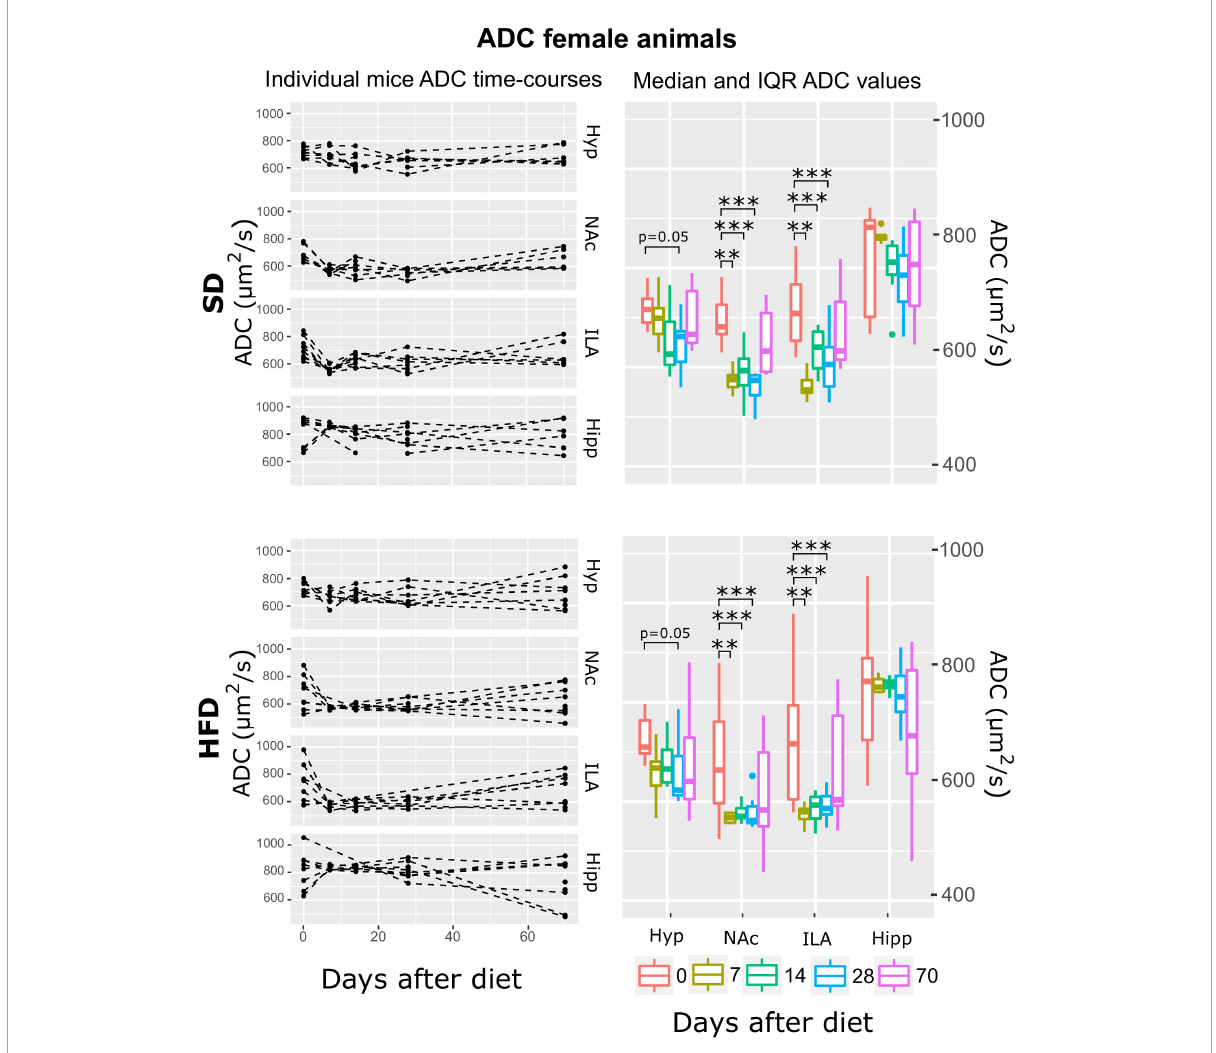
FIGURE7 ADC changes on female mice during HFD or SD consumption. ADC time-evolution on SD-fed (top panels) or HFD (bottom panels) female mice in the four brain areas assessed: hypothalamus (Hyp), nucleus accumbens (NAc), ipsilateral area (ILA) and hippocampus (Hipp) at all time points measured. Left panels depict the individual regional values at each time point, with dashed lines connecting the neighboring points. Right panels depict box plots of ADC vs. time for the 4 regions studied, with each color corresponding to the same time-point, in days after diet diversification. Note how ADC decreases during the first measurements under both diets (** p < 0.01, *** p <